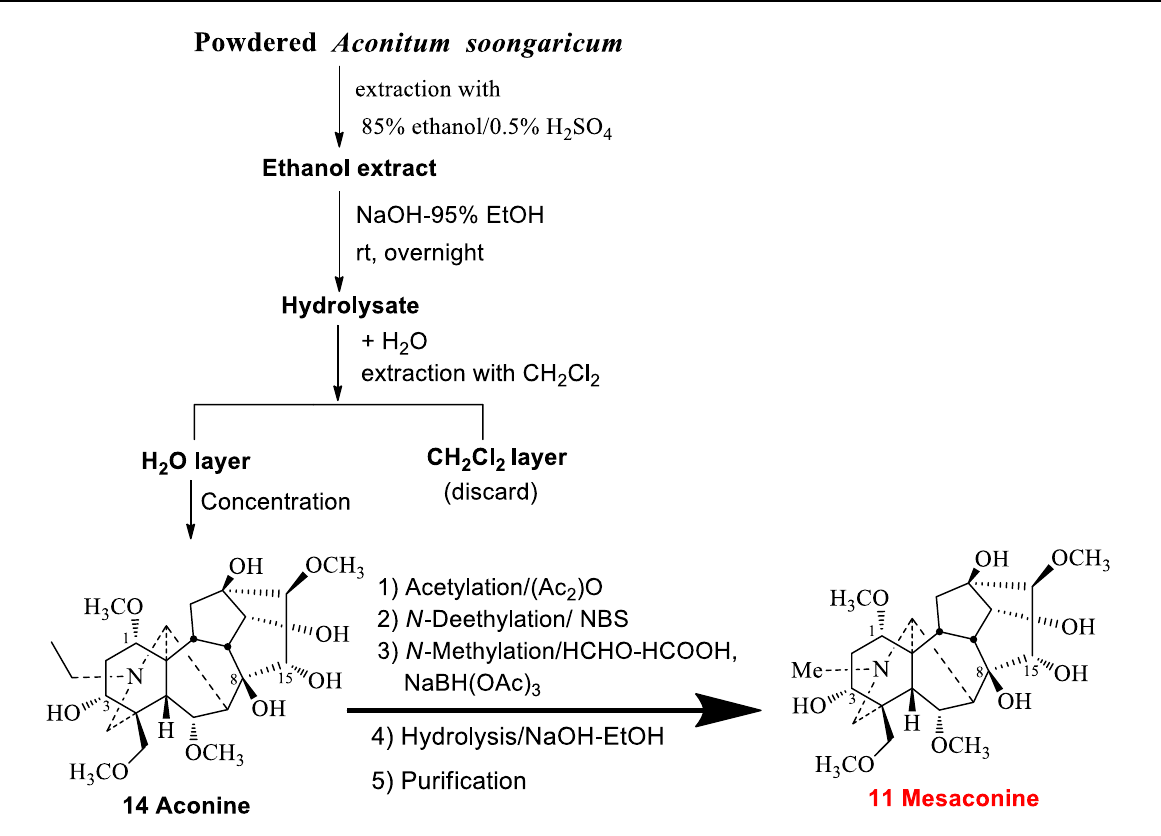
Fig. 4 Industrial preparation process for Mesaconine ( 11